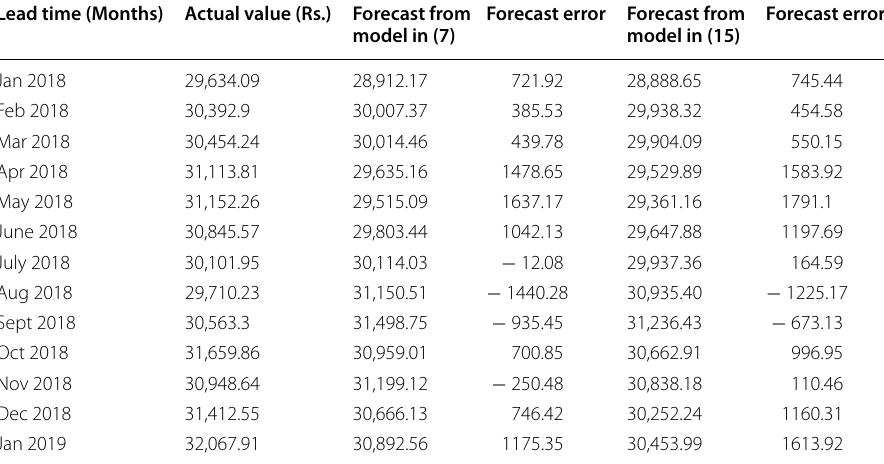
Table 3 Comparison of actual values and forecast values between models (7) and (15) and their associated forecast errors Lead time (Months) Actual value (Rs.) Forecast from